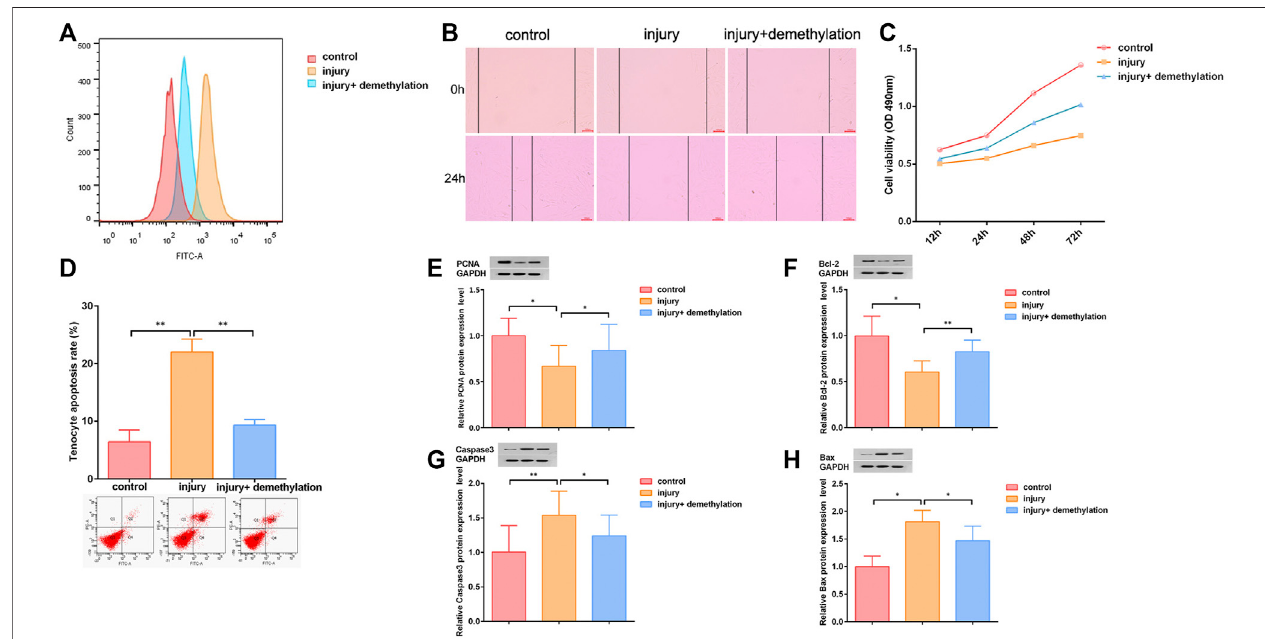
FIGURE 2 | LncRNA Morf4l1 inhibited oxidative stress and promoted proliferation of tenocytes. (A) Flow cytometry analysis was used to detect the level of ROS. Theoxidativestresslevelofinjuredtenocytes wasreducedafter demethylation (B) Wound-healingwasusedtodetecttheeffect ofdemethylation onthemigrationability ofinjuredtenocytes;Scale:100 μ m (C) CCK-8assaywasusedtodetecttheproliferationabilityofinjuredtenocytesafterdemethylation (D) Flowcytometry analysiswas used to detect the apoptosis of injured tenocytes after demethylation (E – H) Western blot was performed to detect the expression of PCNA, Bcl-2, Caspase3 and Bax of injured tenocytes after demethylation ( n = 3; Mean ± SD, * p < 0.05, ** p < 0.01, *** p < 0.001; Student ’ s t-tests).